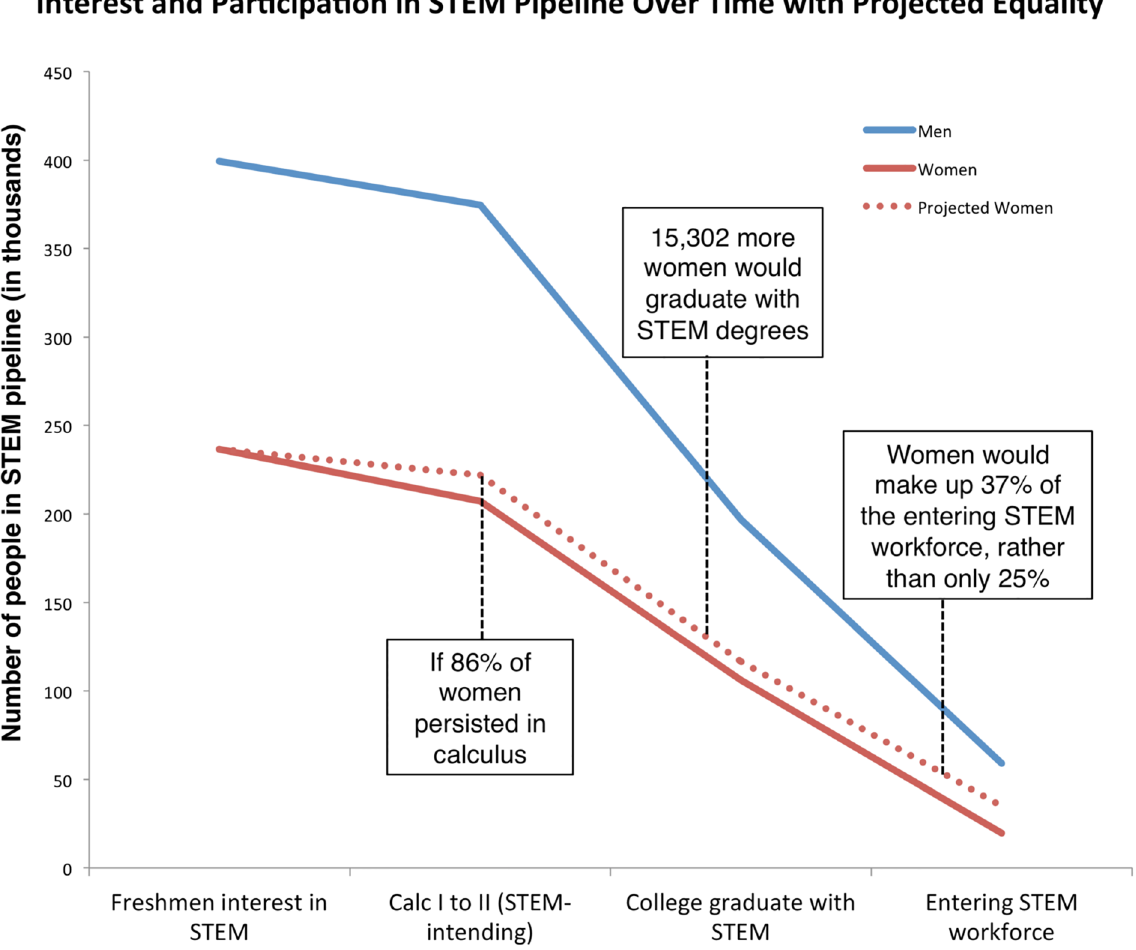
Fig 5. Projected participation of STEM if women and men persisted at equal rates after Calculus I. The dotted line represents the projected participation of women.